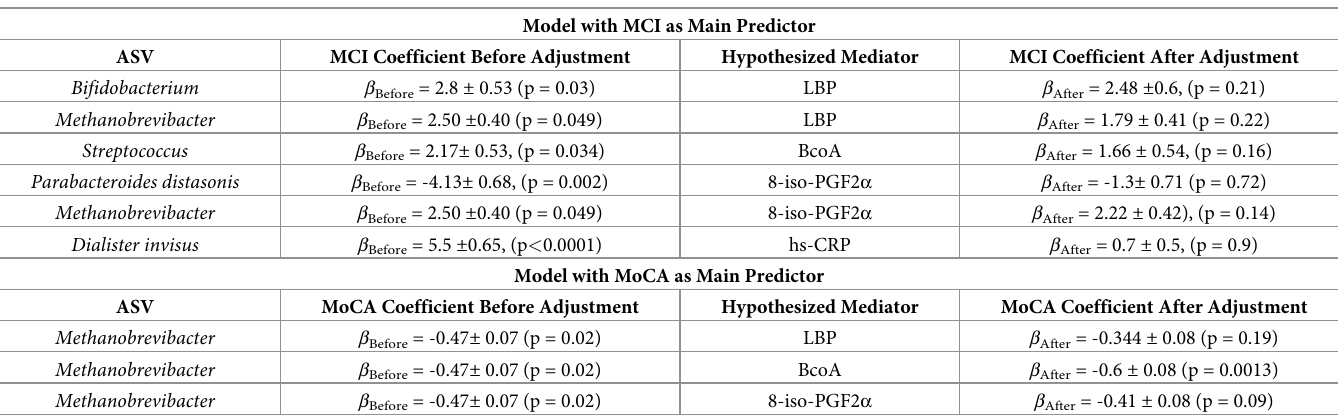
Table 3. Fully adjusted models with MCI � or MoCA �� as main